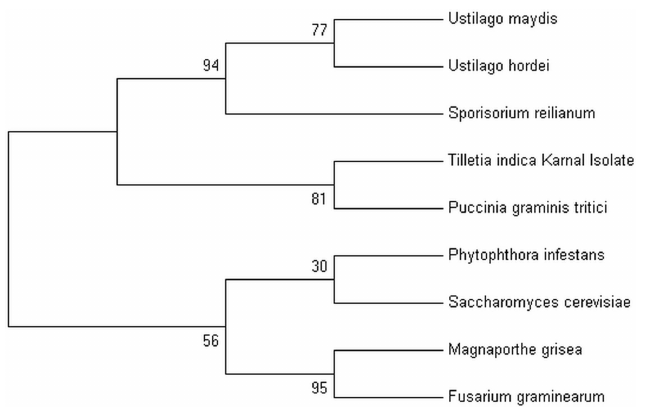
Fig 6. Phylogenetic tree showing relationship of T . indica genome with genomes of other phytopatho- genic fungi. Maximum Likelihoodtree was constructed using ITS1, 5.8S, ITS2 sequencesusing MEGA version7, (Tamura 3-parameter model) with 1000